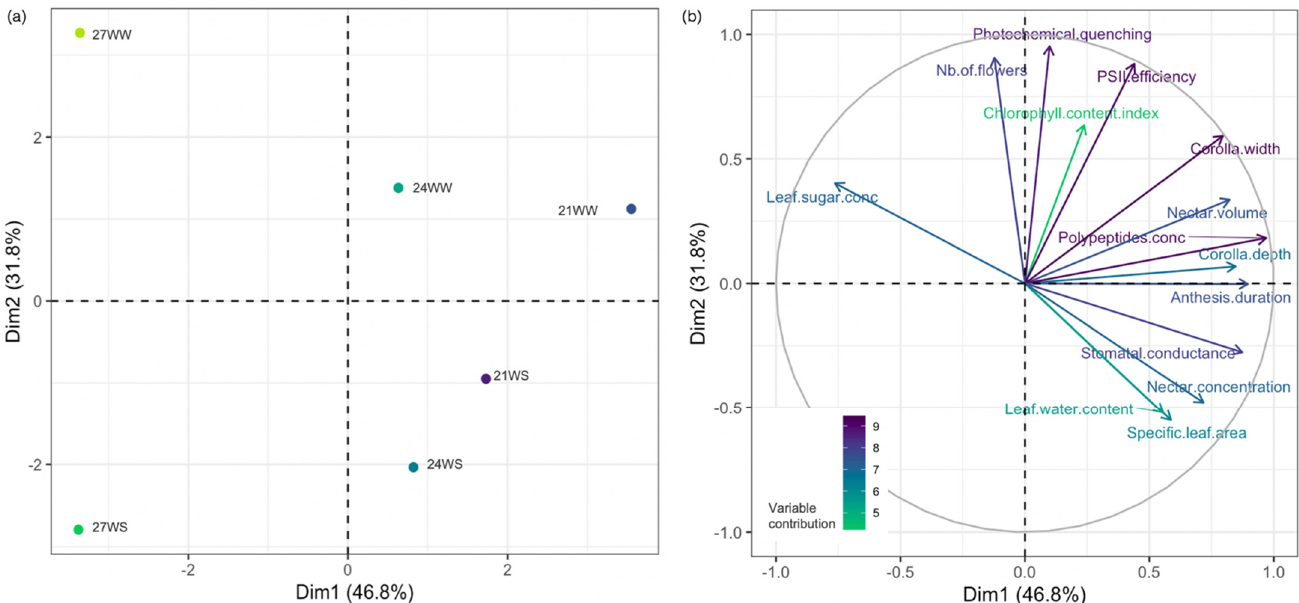
Figure 3. Principal component analysis (PCA) of vegetative, physiological and floral traits and resources of Impatiens glandulifera plants grown under three temperatures (21, 24, 27 °C) and two watering regimes (WW, well-watered; WS, water stressed) for 2 weeks. ( a ) Individual graph showing the different treatments; ( b ) variable graph of PCA showing vegetative, physiological, floral traits and floral reward parameters. conc = concentration, PSII = photosystem II. 21, 21 °C; 24, 24 °C; 27, 27 °C; WS, water-stressed; WW, well-watered. 21WW = control.